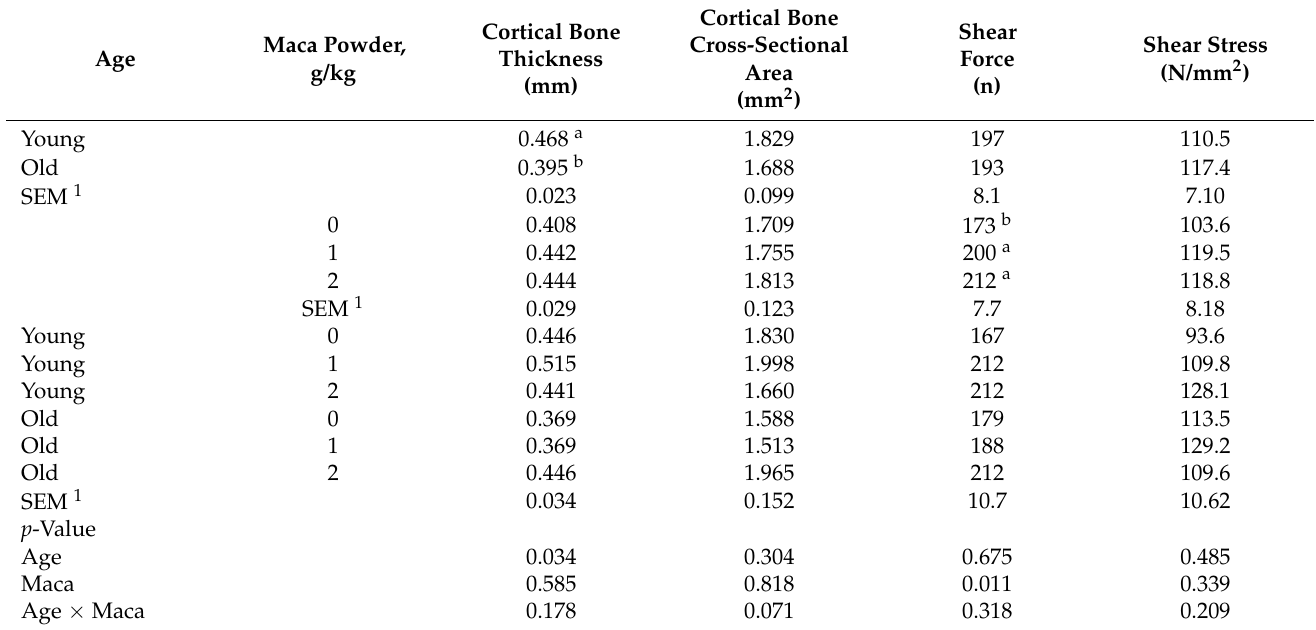
Table 7. Effects of Maca powder supplementation in diets of laying quails at different ages on bone biomechanical